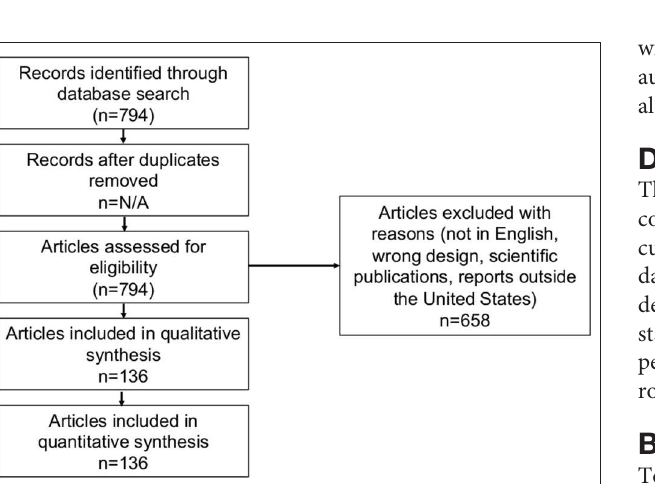
FIGURE 2 | PRISMA flow chart of the systematic review of public opinions about raw milk consumption in the United States.